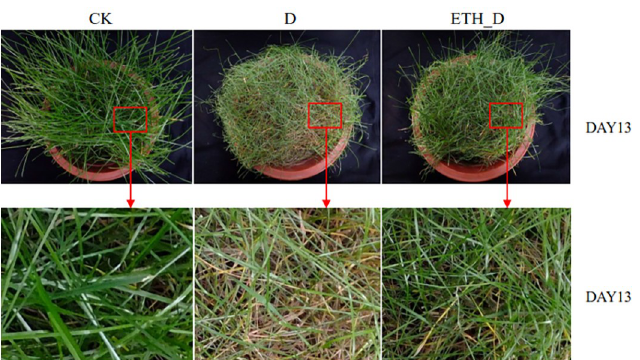
Fig 3. Effects of ethephon on Kentucky bluegrass under drought. CK means well-watered control plants without ethephon application. Drought means drought-stressed plants without ethephon pre-treatment. ETH_D means drought-stressed plants with ethephon pre-treatment.